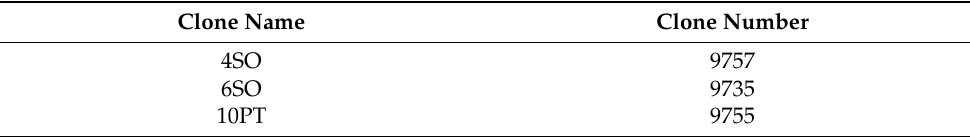
Table 1. Name and number of selected clones of black